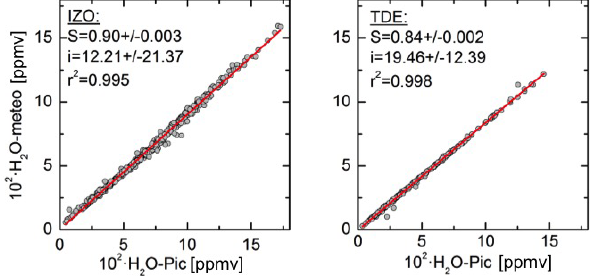
Figure A1. Grey dots show the 1h humidity data pairs of the Picarro and the meteorological at IZO and TDE. Red lines indicate the lin- ear fit of the distribution. S = slope, i = intercept, r 2 = coefficient of